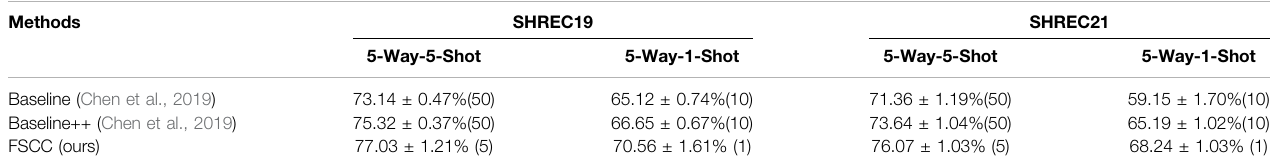
TABLE2| Classi fi cationperformanceofFSCCandSOTAmethodsonthesyntheticdataset.Theclassi fi cationperformanceismeasuredbyclassi fi cationaccuracy,followed by the number of labeled training macromolecules in